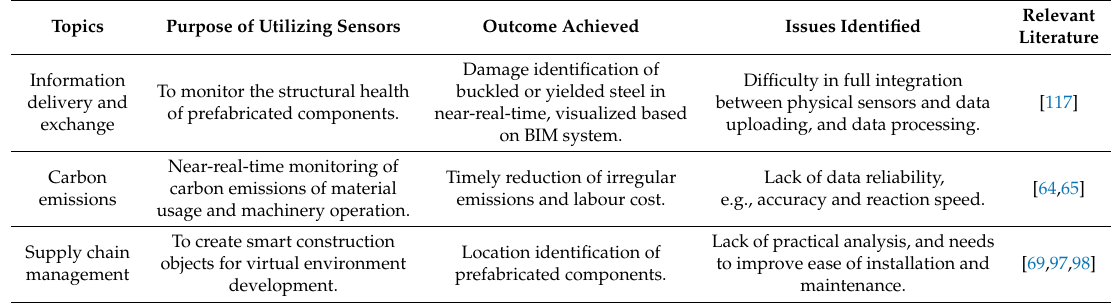
Table 9. Research topics, purpose of sensors adoption, and outcomes achieved in previous